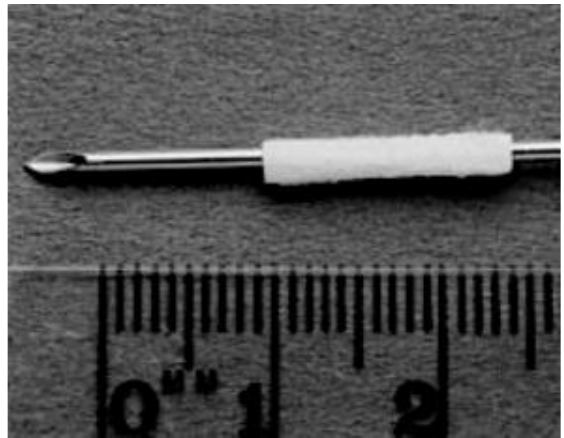
Figure 4. Unidirectional fiber orientated sheet of PHB (8 × 14 mm) rolled around a 16 G cannula to form a tube 14 mm long and with an internal diameter of 1.6 mm. Reused from (Hazari et al., 1999b) [16] with kind permission of Elsevier.